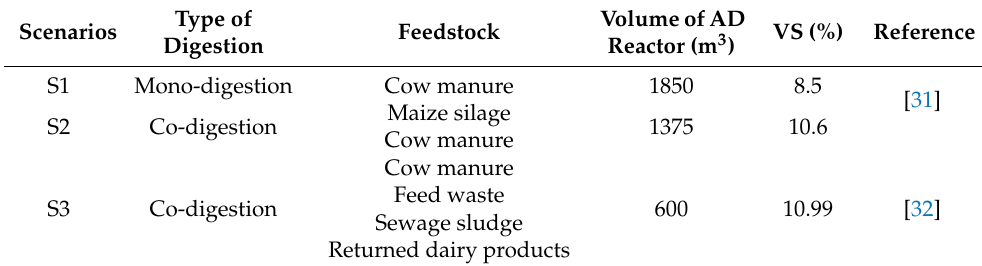
Table 1. Summary of biogas plant